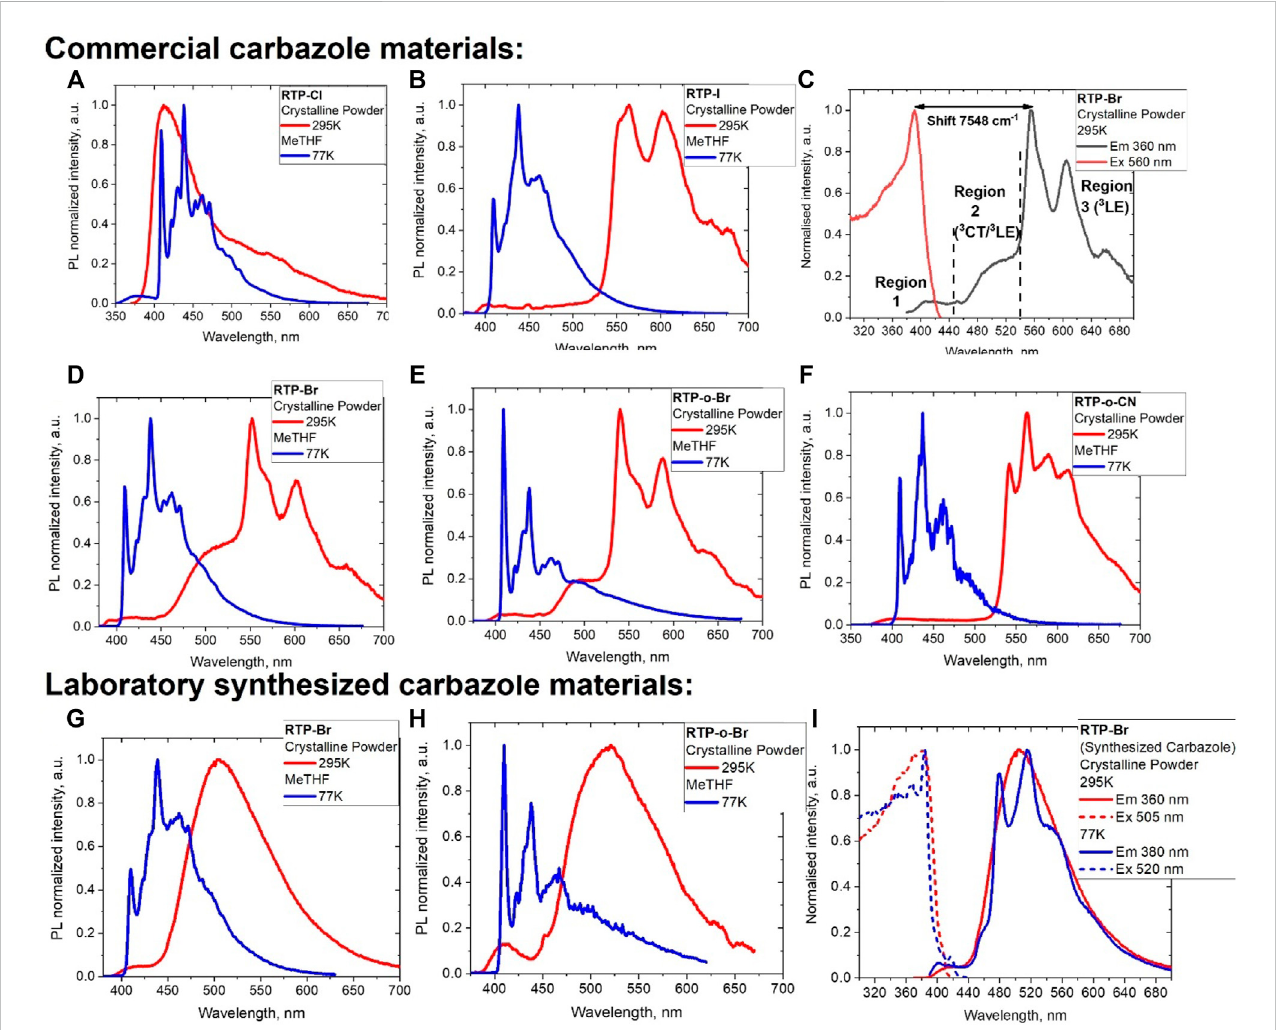
FIGURE 2 Photoluminescent spectra in crystalline powder at 295 K (red, excited at 360 nm) and frozen MeTHF solution at 77 K (blue, excited at 320 nm) for (A) RTP-Cl ; (B) RTP-I ; (C) RTP-Br emission (360 nm) and excitation (560 nm) pro fi les with three luminescence regions: fl uorescence (region 1), phosphorescence (region 2), and room temperature persistent phosphorescence (region 3); (D) RTP-Br ; (E) RTP- o -Br ; and (F) RTP-o-CN . Photoluminescent spectra in crystalline powder at 295 K (red, excited at 360 nm) and frozen MeTHF solution at 77 K (blue, excited at 320 nm) for materials obtained from the laboratory synthesized carbazole: (G) RTP-Br , (H) RTP- o -Br , and (I) emission (360 nm) and excitation (560 nm) pro fi les for RTP-Br